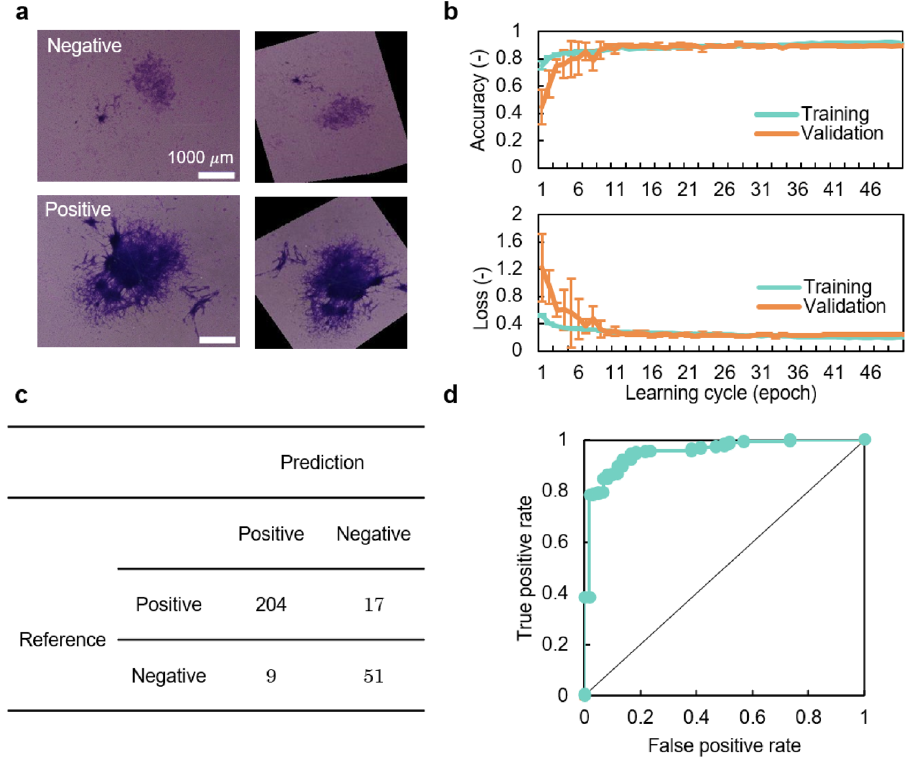
Figure 3. Performance of CNN algorithm. ( a ) Representative images of transformed foci induced by exposure to TPA. Two experts classified the images into positive and negative foci. ( b ) Learning curves. The mean and standard deviation for 5 independent trials are plotted. ( c ) Confusion matrix. The confusion matrix when the AUC value is the median value out of 5 trials is posted. ( d ) ROC curve for test dataset. ROC curve when AUC value is median value out of 5 trials. The average AUC of 5 trials is 0.95 (±